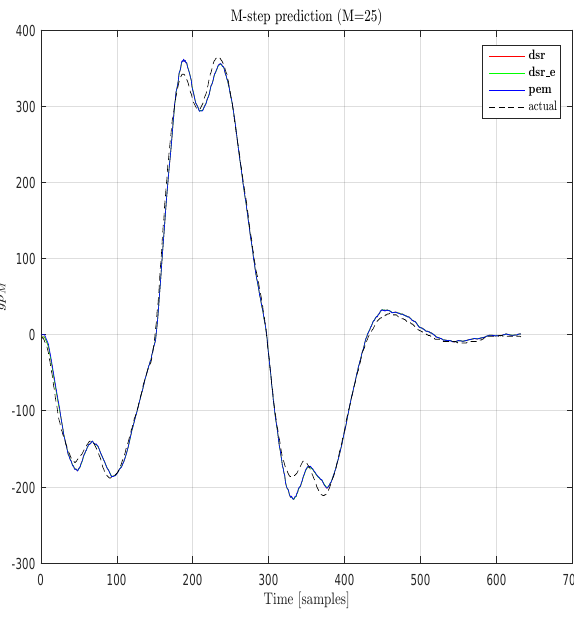
Figure 6: Example 4.3. The figure shows the compar- ison of the simulated output, y d , from the k Figure 7: Example 4.3. The figure shows an M-step algorithms dsr , dsr e and pem , with the ahead prediction of the output y k from the actual output, y k (validation). The corre- dsr , dsr e and pem models with M = sponding criterion, i.e. the mean square er- ror, are given in Table 3.